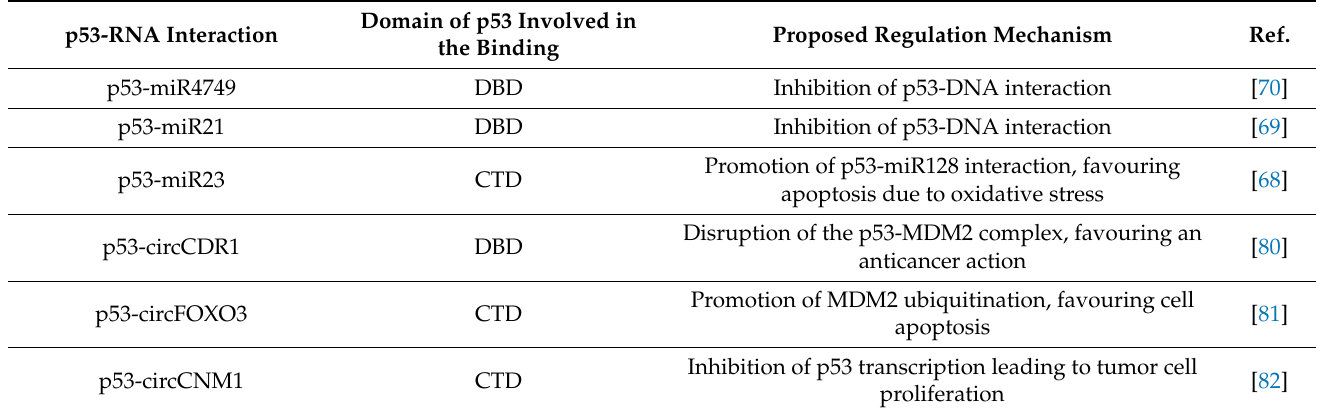
Table 1. Summary of the interaction properties between p53 and the investigated non-coding RNA. p53-RNA